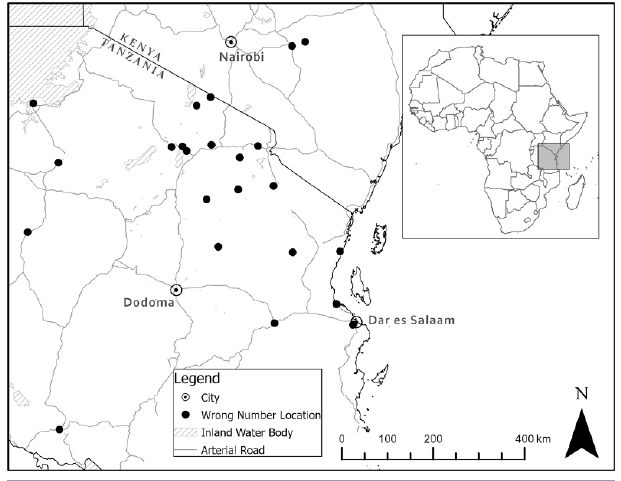
Fig. 2 . Map of the locations of wrong number connections described during group